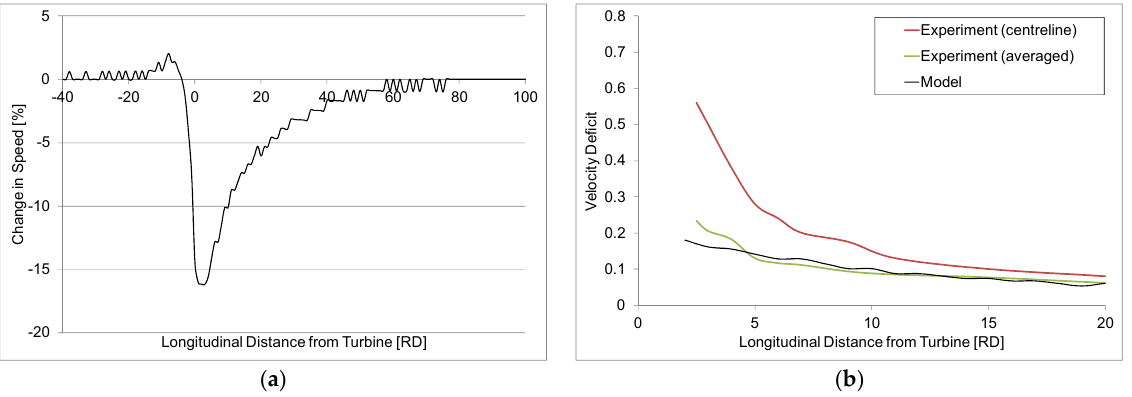
Figure 6. ( a ) Changes in current speed along the longitudinal wake centreline and ( b ) comparison of modelled and measured velocity deficits along the same centreline.